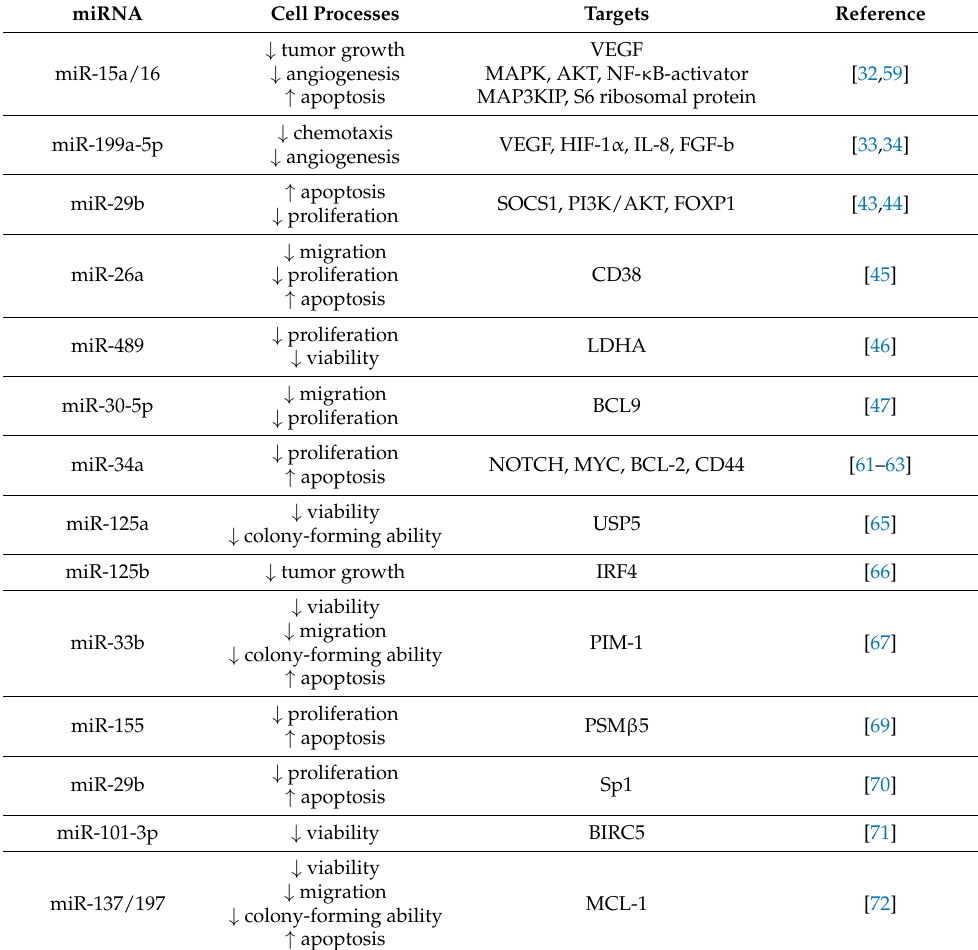
Table 2. List of selected tumor suppressor miRNAs in MM. ↑ —increased expression, ↓ —decreased